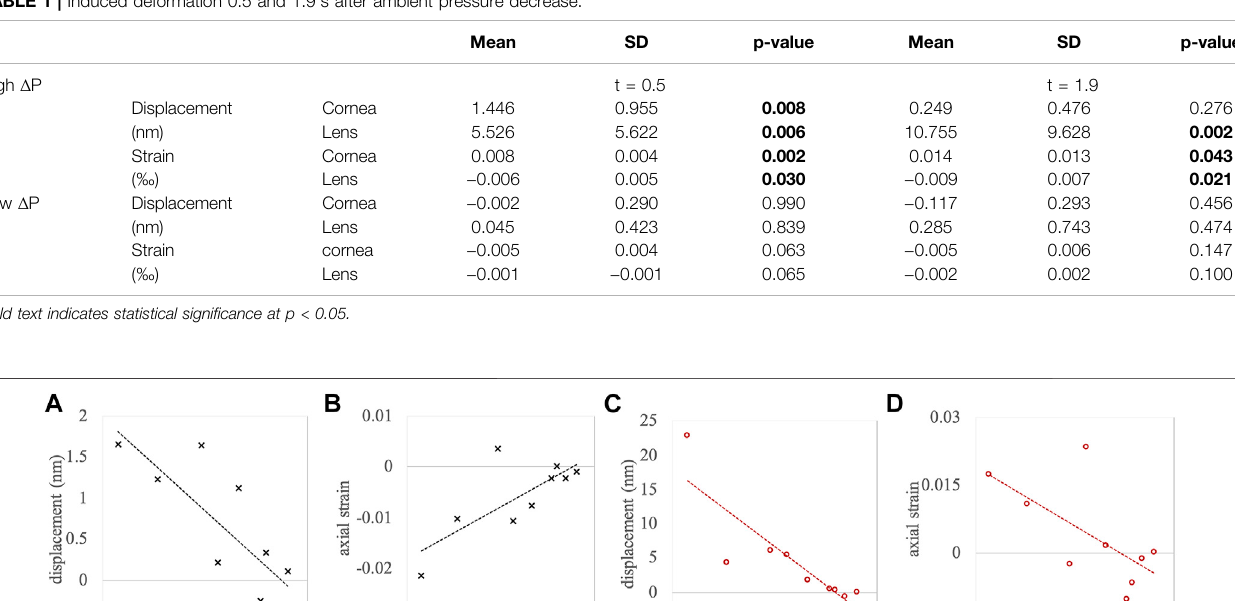
TABLE 2| Pearson correlationcoef fi cients of the pressure change with measured parameters, applied to the complete data set (n (cid:2) 9).